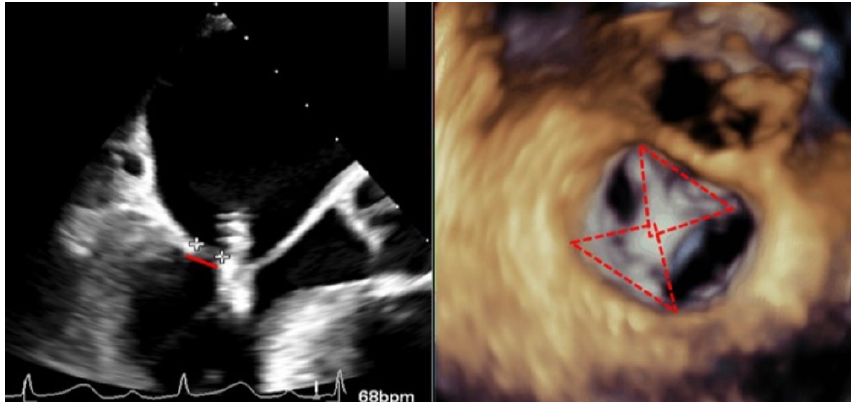
Figure 4. Transesophageal echocardiogram during grasping. ( Left ) Two-dimensional transesophageal echocardiogram in the view of the left ventricular outflow tract, showing the tension of both leaflets and the measurement of the posterior leaflet introduced in the clip (red line delimited by plus sings). ( Right ) En-face 3D transesophageal echocardiogram view of the mitral valve with a clip between A2 and P2 with 2 symmetrical pyramids (red dotted lines).